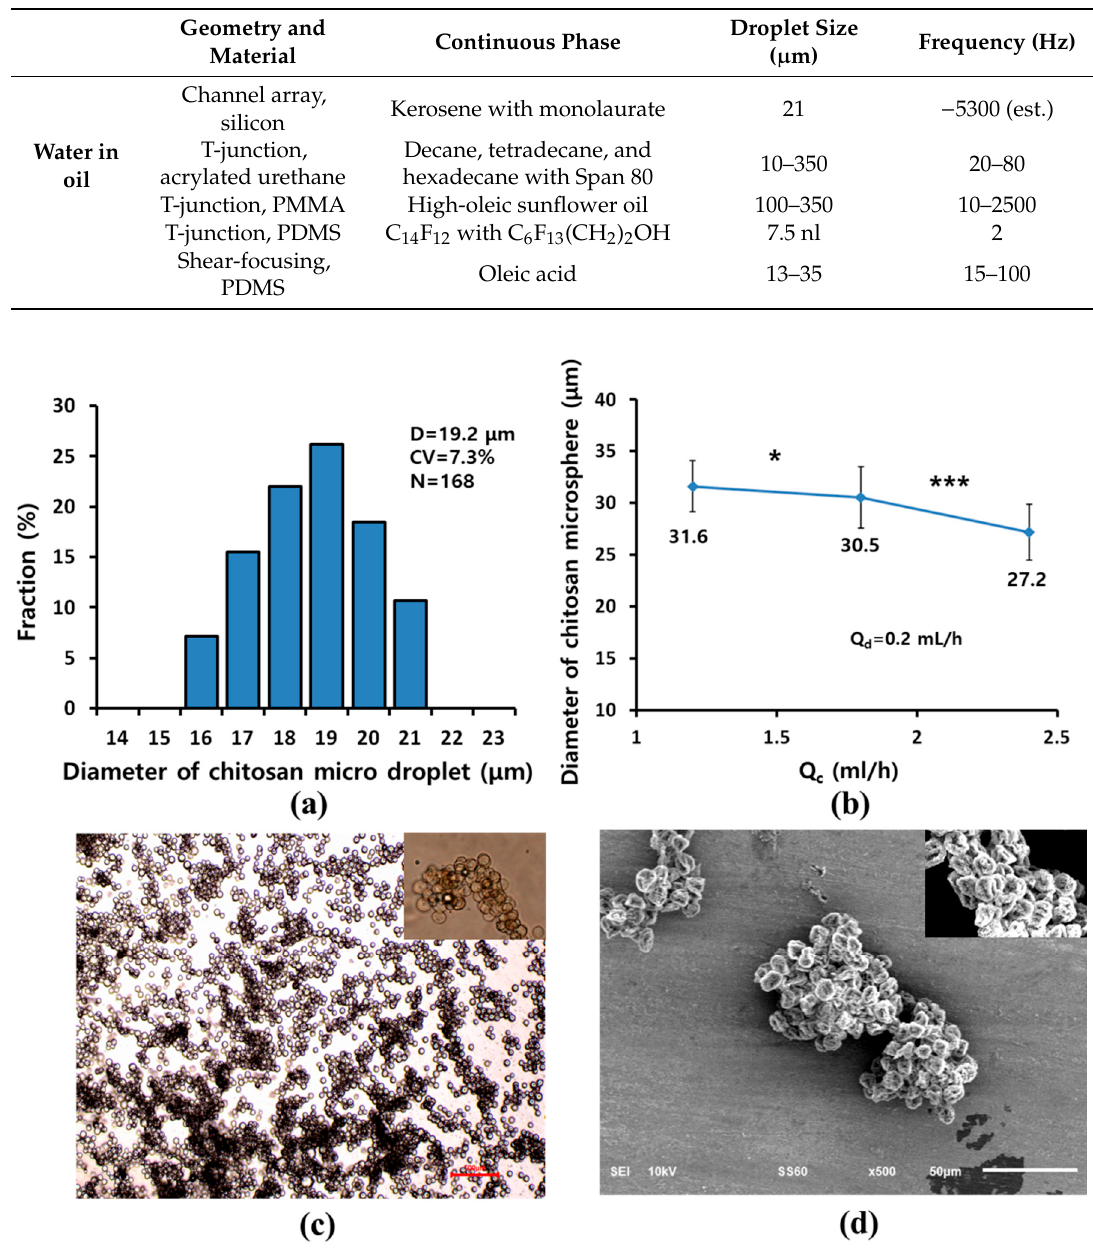
Figure 8. ( a ) Size distribution of chitosan microspheres produced using the 512-channel geometrical passive breakup device for Q d and Q c of 0.5 and 1.5 mL/h; ( b ) diameters of chitosan